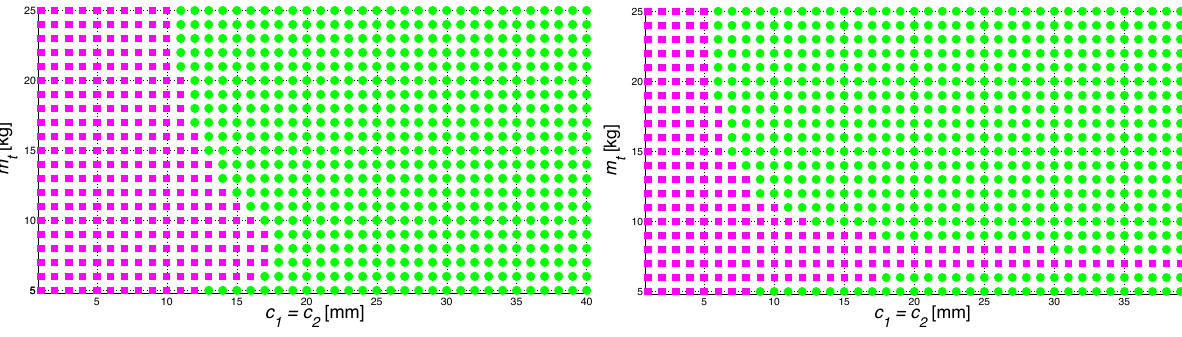
Fig. 6 Impact occurrence dependent on the clearance c 1 = c 2 and the mass of the impact element m t for the excitation frequency (left) ω = 100 rad s − 1 and (right) ω = 115 rad s − 1 . Here, red box = impact occurs, green dot = no